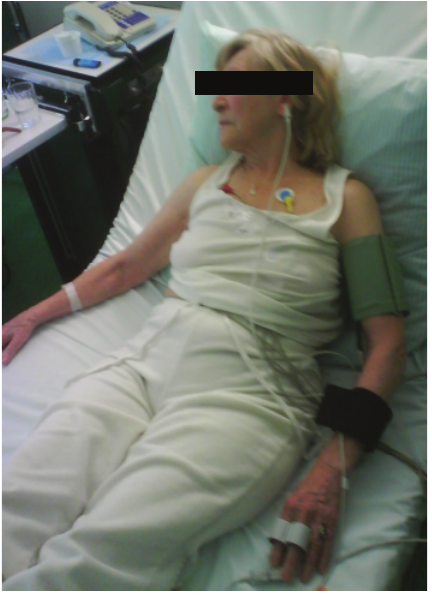
Figure1:Simultaneousandcontinuousmultichannelregistrationof diastolicandsystolicbloodpressureandheartrateinalyingposition at rest.